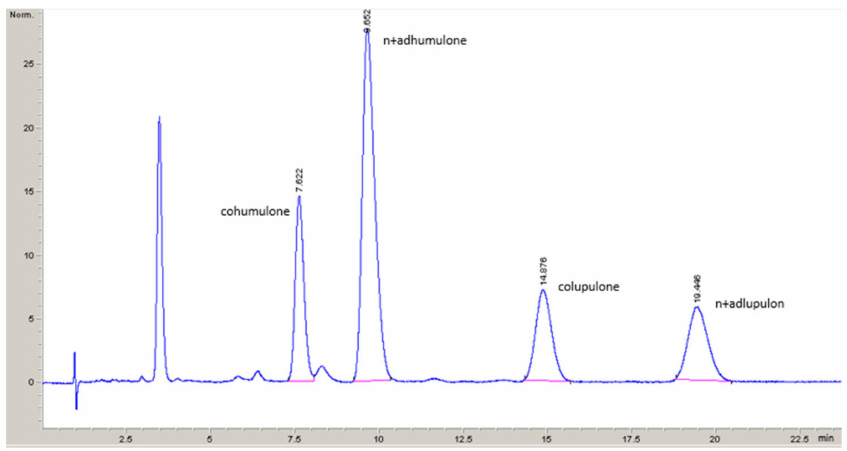
Figure 10. HPLC analysis chromatogram specimen of Aurora variety hop essential